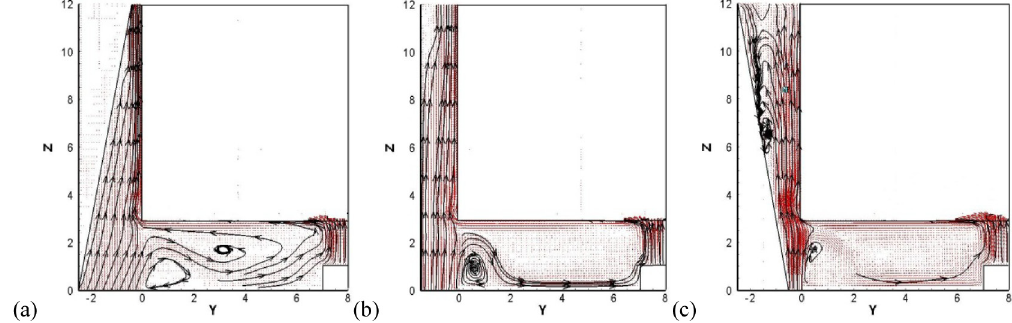
Fig. 13. Velocity vector diagram at the steady state with Q = 5MW when: (a) θ = 80°, (b) θ = 90° and (c) θ = 100°